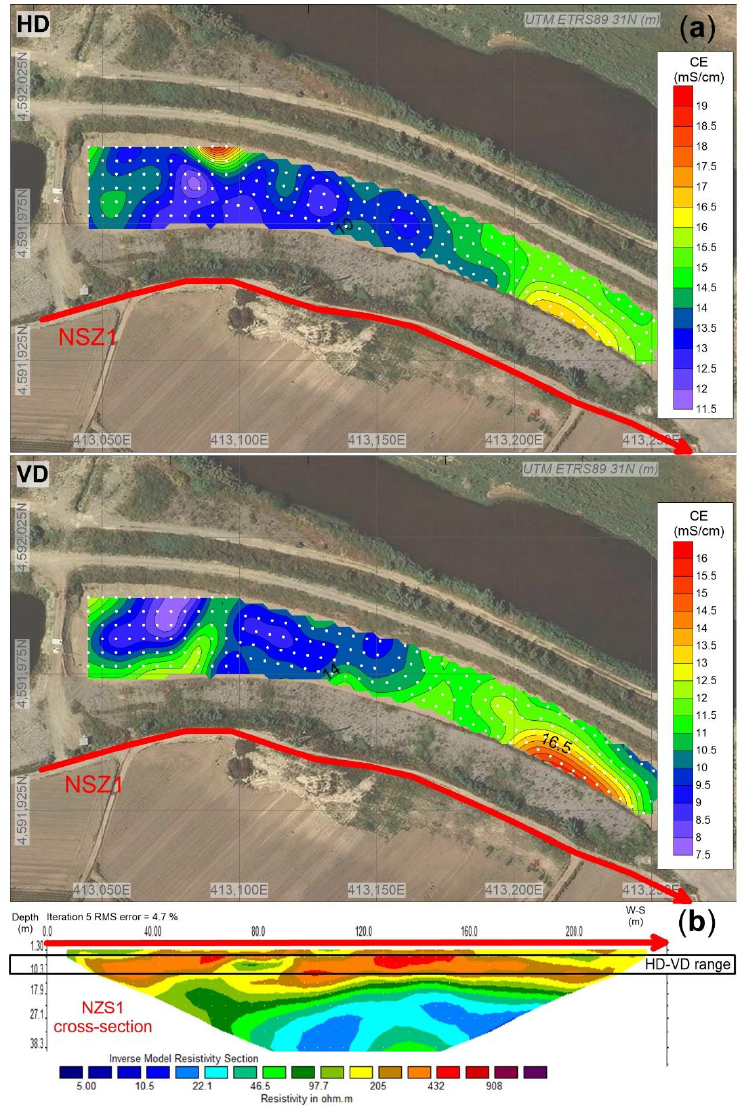
Figure 5. ( a ) Isoconductivity maps obtained from the FDEM survey (represented as white dots). The top image corresponds to Vertical Dipole or VD configuration (6 m deep) and the lower image to Horizontal Dipole or HD configuration (3 m deep). ( b ) ERT cross-section acquired at the southern margin of the pond.